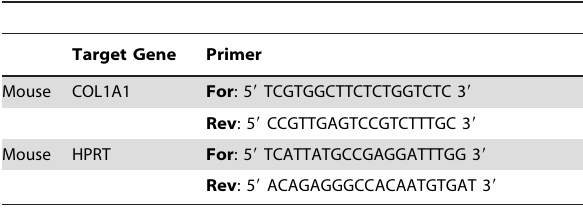
Table 2. Primer nucleotide sequences used for real-time quantitative